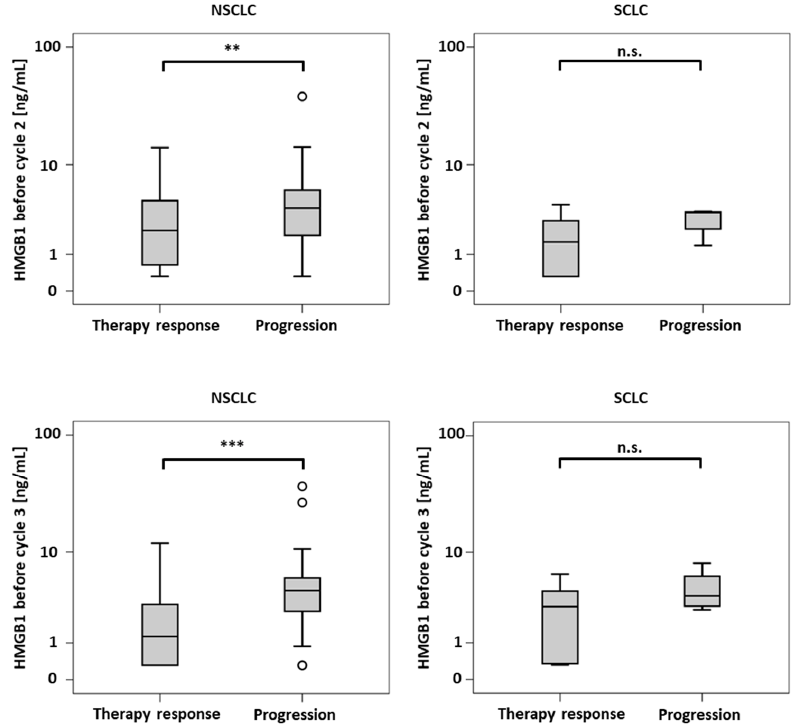
Figure 1. Boxplots of concentrations of high mobility group box 1 protein (HMGB1) before the second (top) and third therapy cycle (bottom) for non-small-cell lung carcinoma (NSCLC) (left) and small-cell lung carcinoma (SCLC) patients (right). n .s.: not significant, **: p < 0.01, ***: p < 0.001. Table 2. Prediction of therapy response in NSCLC by biomarkers.